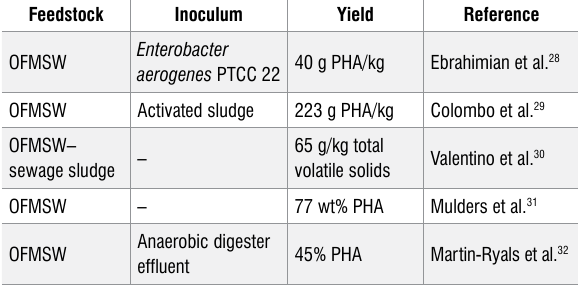
Polyhydroxyalkanoate (PHA) yields from various studies employing the organic fraction of municipal solid waste (OFMSW) as a feedstock